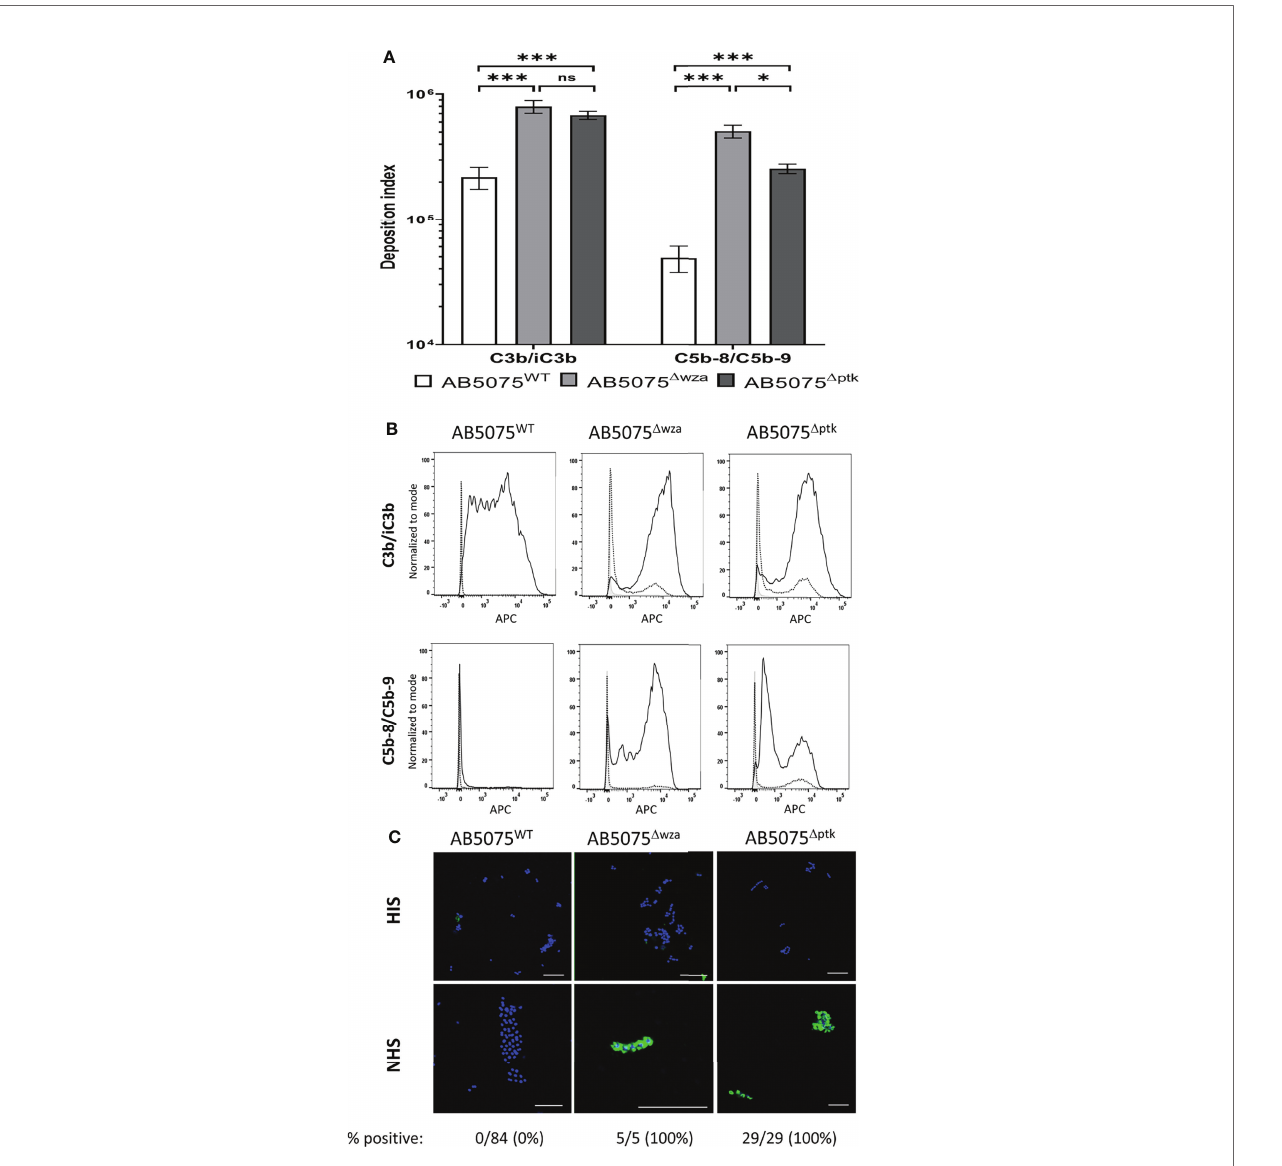
FIGURE 1 | C3b/iC3b and C5b-8/C5b-9 deposition on the surface of wild-type and unencapsulated AB5075 isolates. 10 6 CFU of bacteria was incubated with 25% normal human sera followed by incubation with either the mouse monoclonal antibody 6C9 (Millipore) or aE11 (Abcam) and detected using an anti-mouse IgG conjugated to either allophycocyanin (APC) (Jackson Immunoresearch) (A) Bar graph showing the deposition index calculated by multiplying the percentage of bacteria staining positive for the respective complement factor and the median fl uorescent intensity of the positive population. Bacteria incubated with PBS only followed by the primary and secondary antibody was used to determine the negative population. (B) Representative histograms showing the deposition of C3b/iC3b (top panel) and C5b-8/C5b-9 (bottom panel) on 10 6 CFU of the AB5075 WT , AB5075 D wza and AB5075 D ptk strains. Each graph shows a grey histogram that represents bacteria labelled with primary and secondary antibody only, while the black dotted and solid line represent bacteria incubated with heat-inactivated or normal human sera respectively. (C) Confocal imaging showing C5b-8/C5b-9 deposition on wild-type and unencapsulated AB5075 D wza and AB5075 D ptk isolates following incubation with heat-inactivated sera (HIS) (top panel) or normal human sera (NHS) (bottom panel). Blue represent DAPI stained bacteria and green shows bacteria positive for MAC deposition. Figures below each panel represent the percentage of bacterial cells in each panel showing atleast some green fl uorescent staining representing MAC deposition. A scale bar equivalent to 10 µm is indicated by a white line in all images. Bars represent mean values for each condition/strain and the error bars indicate standard deviations (SDs) (n = 3). T-test was used for statistical analysis *: p-value < 0.05, ***: p-value < 0.001, ns: p-value > 0.05. Representative data from two independent experiments is